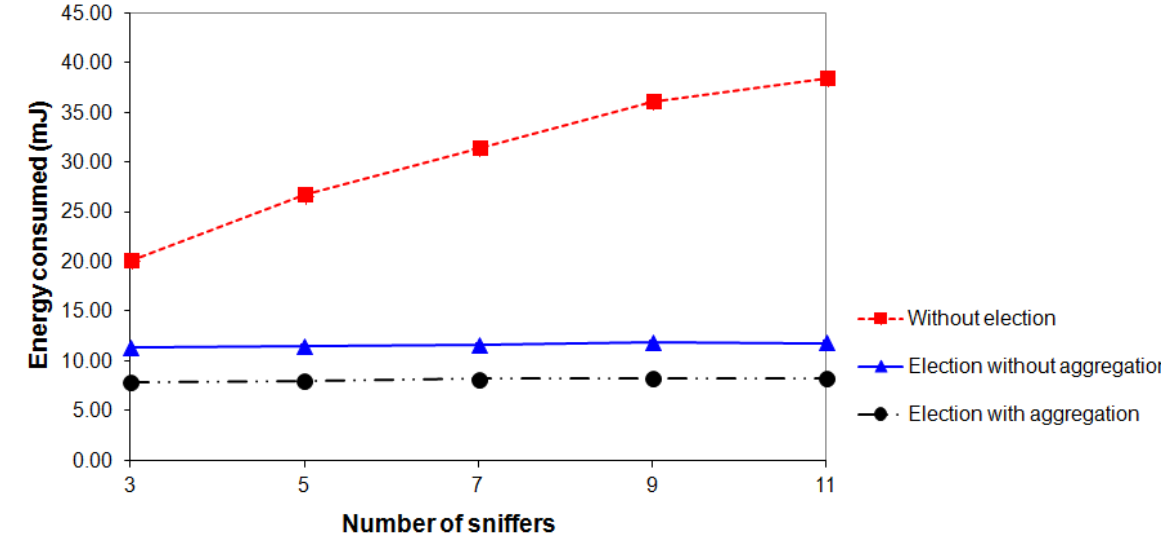
Figure 13. Energy consumed by the monitoring network vs . number of